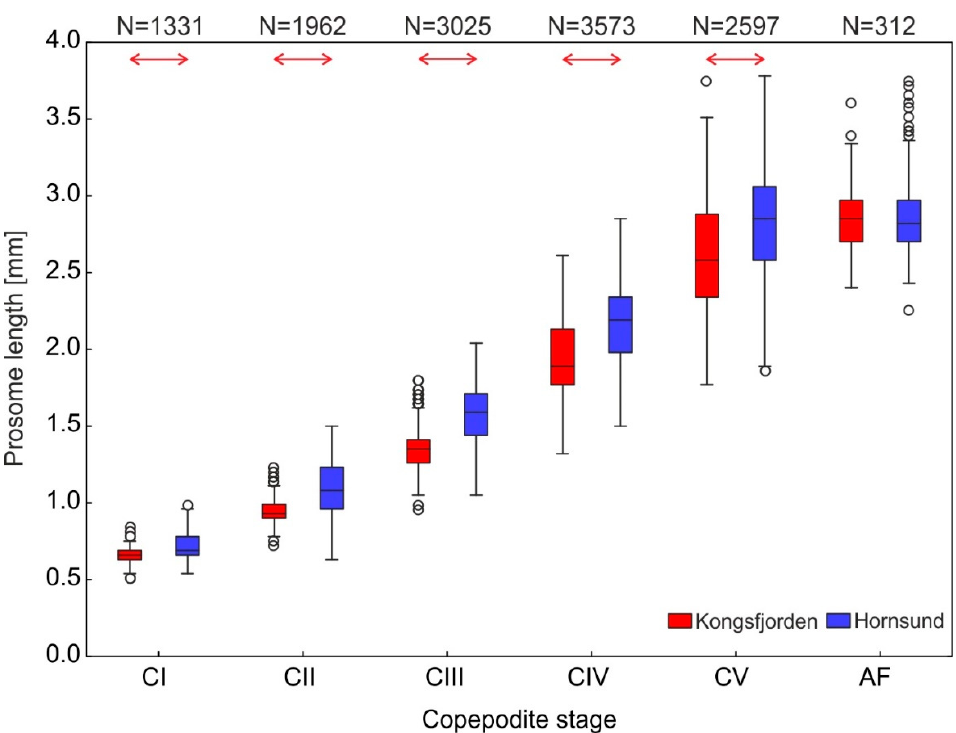
Figure 2. Prosome length of Calanus copepodite stages: CI–adult females (AF) in Kongsfjorden (red) and Hornsund (blue). Horizontal black lines in the boxes show the median, box represents percentiles, whiskers indicate ranges, dots represent values outside the range, red arrows show statistically significant size di ff erences between two investigated fjords, N indicates number of measured individuals.